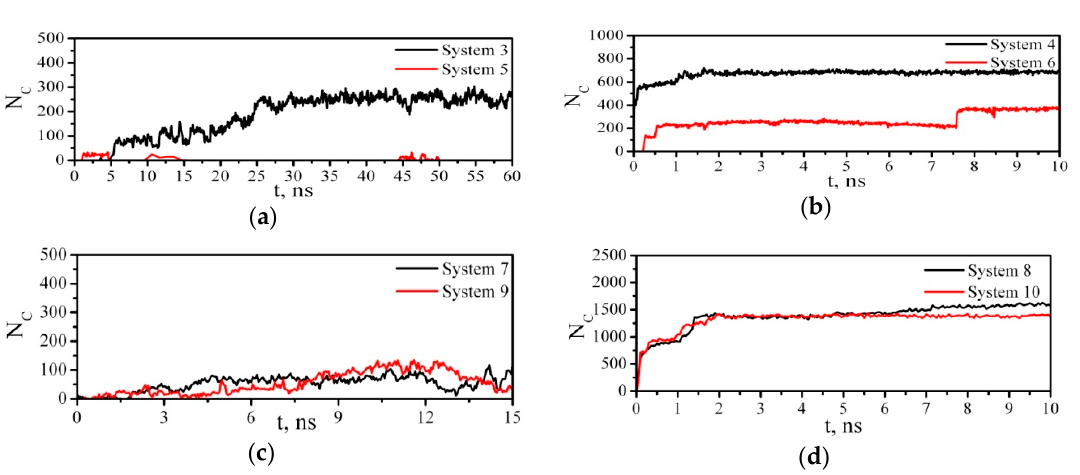
Figure 5. Time dependence of the number of contacts between any pair of atoms of PAM and CNC within a given distance of 0.5 nm. For System 5 when NC = 0, the red line coincides with the abscissa and therefore is not visible in the figure. ( a ) Systems 3 and 5, ( b ) Systems 4 and 6, ( c ) Systems 7 and 9, ( d ) Systems 8 and